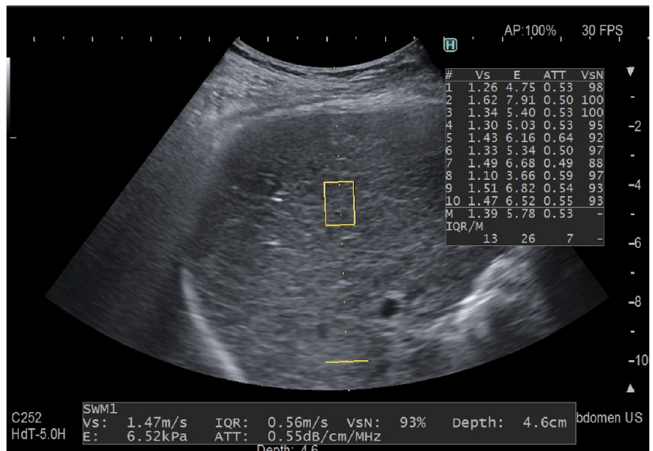
Figure 1. Fat quantification with the previous ATT algorithm. The yellow rectangle is the region of interest (ROI) for stiffness measurement and the yellow horizontal line indicates the depth of the ATT measurement area in the far field, which is set at 100 mm. The ATT measurement area has a fixed size and the measurement of the attenuation coefficient is given in dB/cm/MHz together with liver stiffness measurement, which is shown both in m/s and kPa. ATT quantifies liver fat content in an areathat has a length of 6 cm and is set at 40–100 mm from the skin. This measurement was taken in a 64-year-old patient with chronic hepatitis C following the protocol for liver stiffness measurement and with a VsN always ≥ 50%. The attenuation coefficient value is within the normal range.